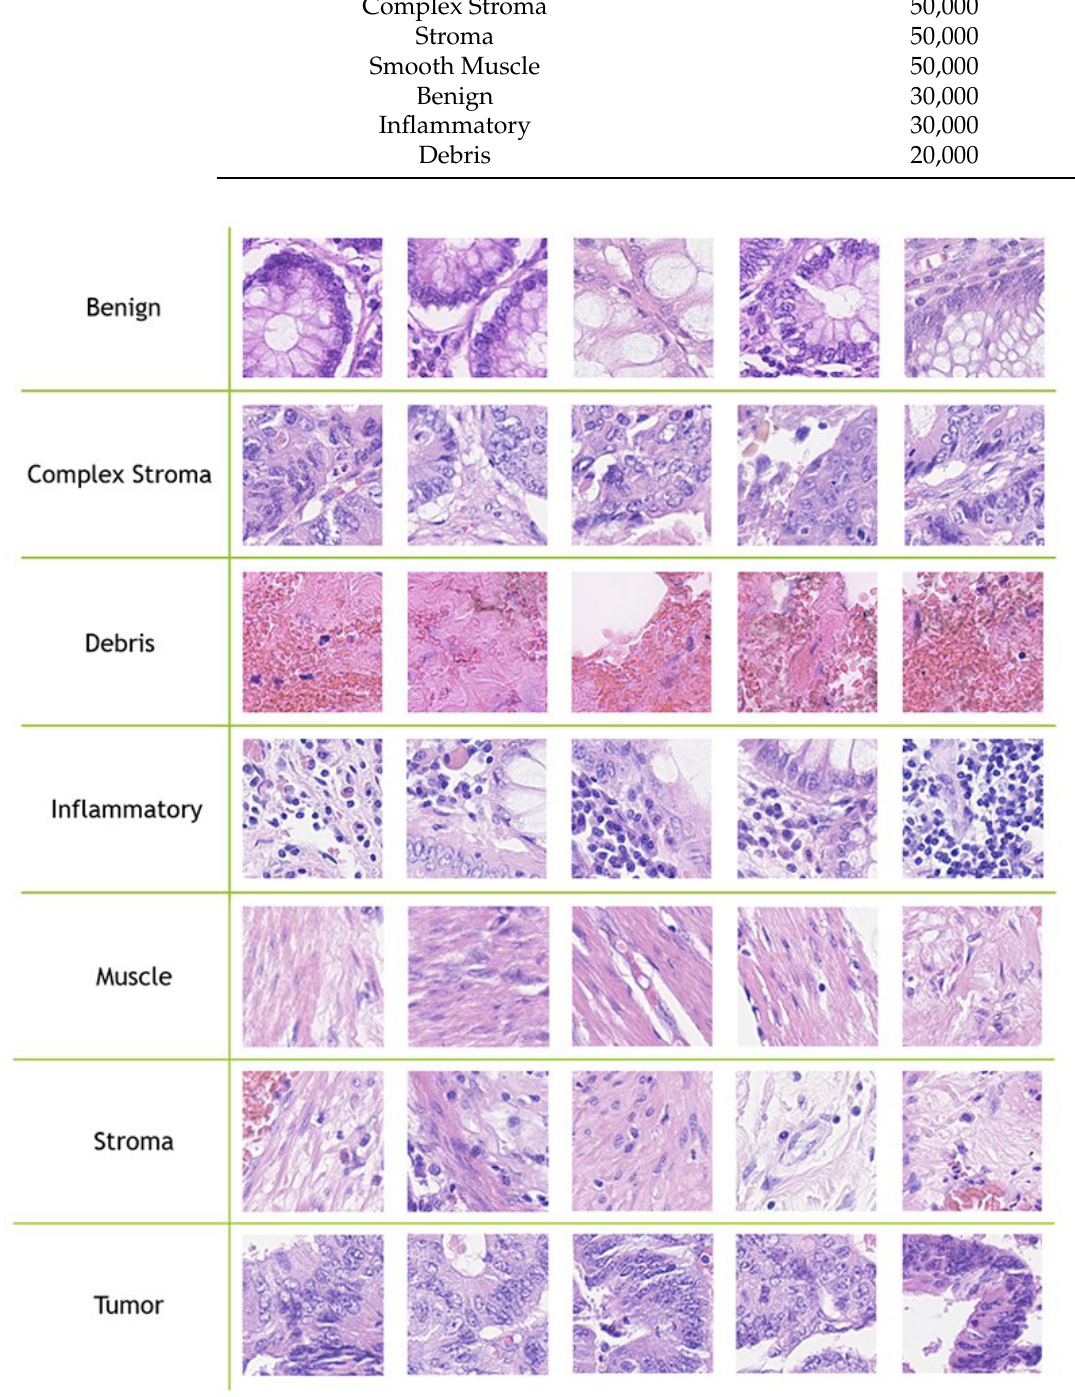
Figure 2. Five samples for each class from the CRC-TP database